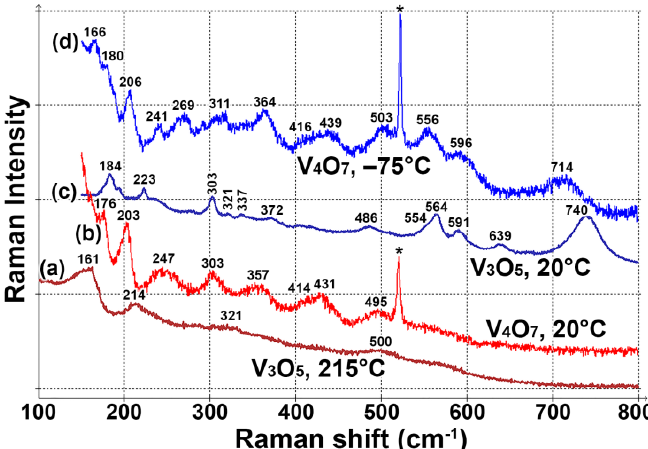
Figure 4. Raman spectra of vanadium oxide Magnéli phases: ( a ) V 3 O 5 , high-temperature modifica- tion, ( b ) V 4 O 7 , high-temperature modification, ( c ) V 3 O 5 , low-temperature modification, ( d ) V 4 O 7 , low-temperature modification. The asterisk marks the position of the Si substrate peak. Temperature-dependent Raman measurements are summarized in Figure 5. Only